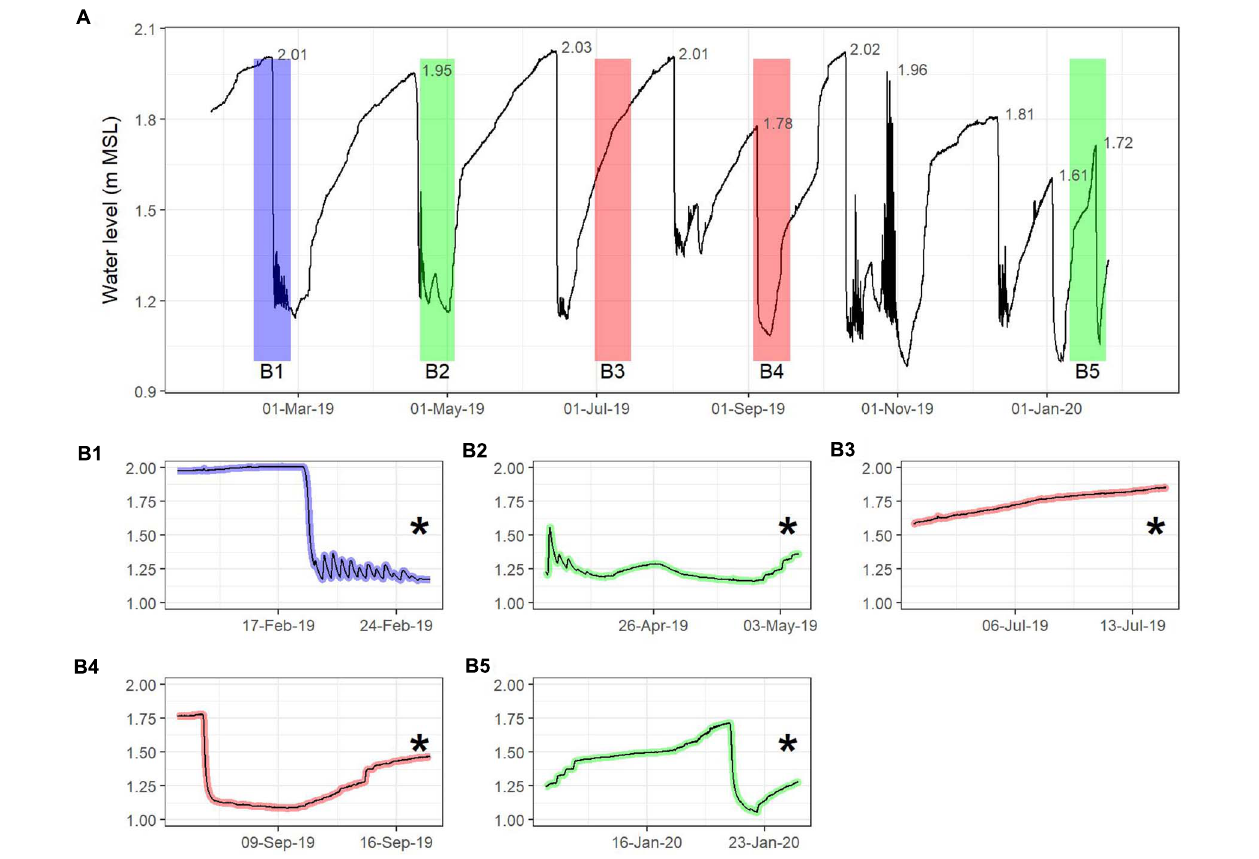
FIGURE 2 | Six-minute interval water level variability (A) recorded throughout the study period (January 24, 2019 to January 25, 2020) at DWS Station K1T010 situated near Site 2 (see Figure 1 ). Short-term fluctuations are indicated for each of the sampling occasions, i.e., February 2019 (B1) , May 2019 (B2) , July 2019 (B3) , September 2019 (B4) , and January 2020 (B5) . A 14-day period prior to the sampling date was chosen for this to represent a full tidal cycle that would encapsulate any overwashing events during closed mouth conditions. Sampling intervals (*) are demarcated according to the degree of mouth connectivity with the marine environment on the day of sampling; including open (blue), semi-closed (green), and closed (red) mouth